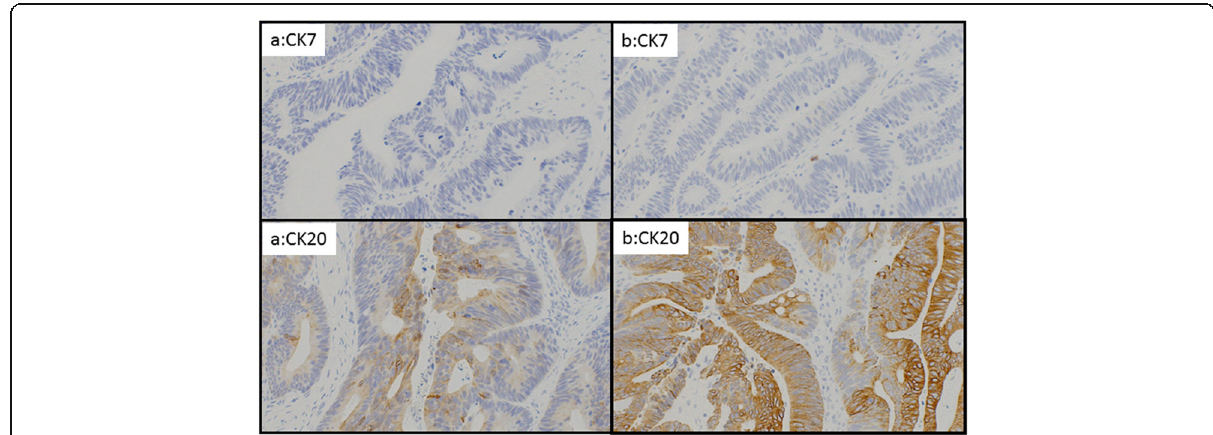
Fig. 4 Immunohistochemical staining of the rectal ( a ) and anal ( b ) carcinomas with cytokeratin (CK) 7 and 20. Both tumors were CK7-negative and CK20-positive